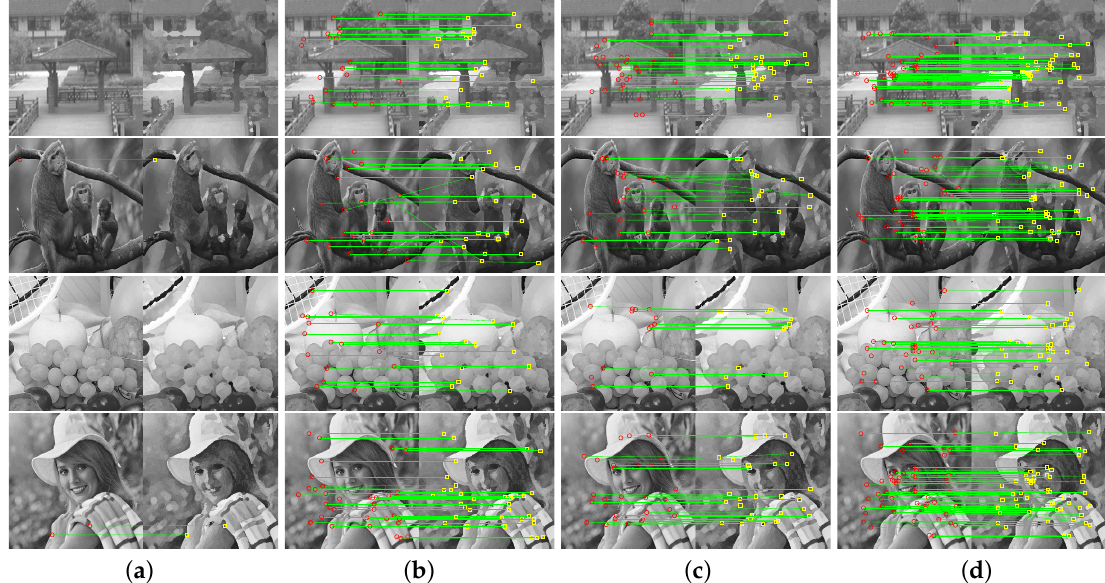
Figure 12. Matching results of heterogeneous images: ( a ) Harris results; ( b ) SIFT results; ( c ) PCA-SIFT results; ( d ) our